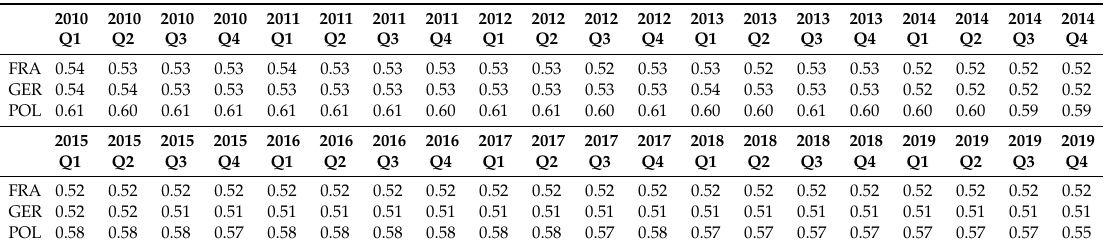
Table 4. Propensity to private consumption—indicator 𝐶𝑃 , own work, source: Eurostat.